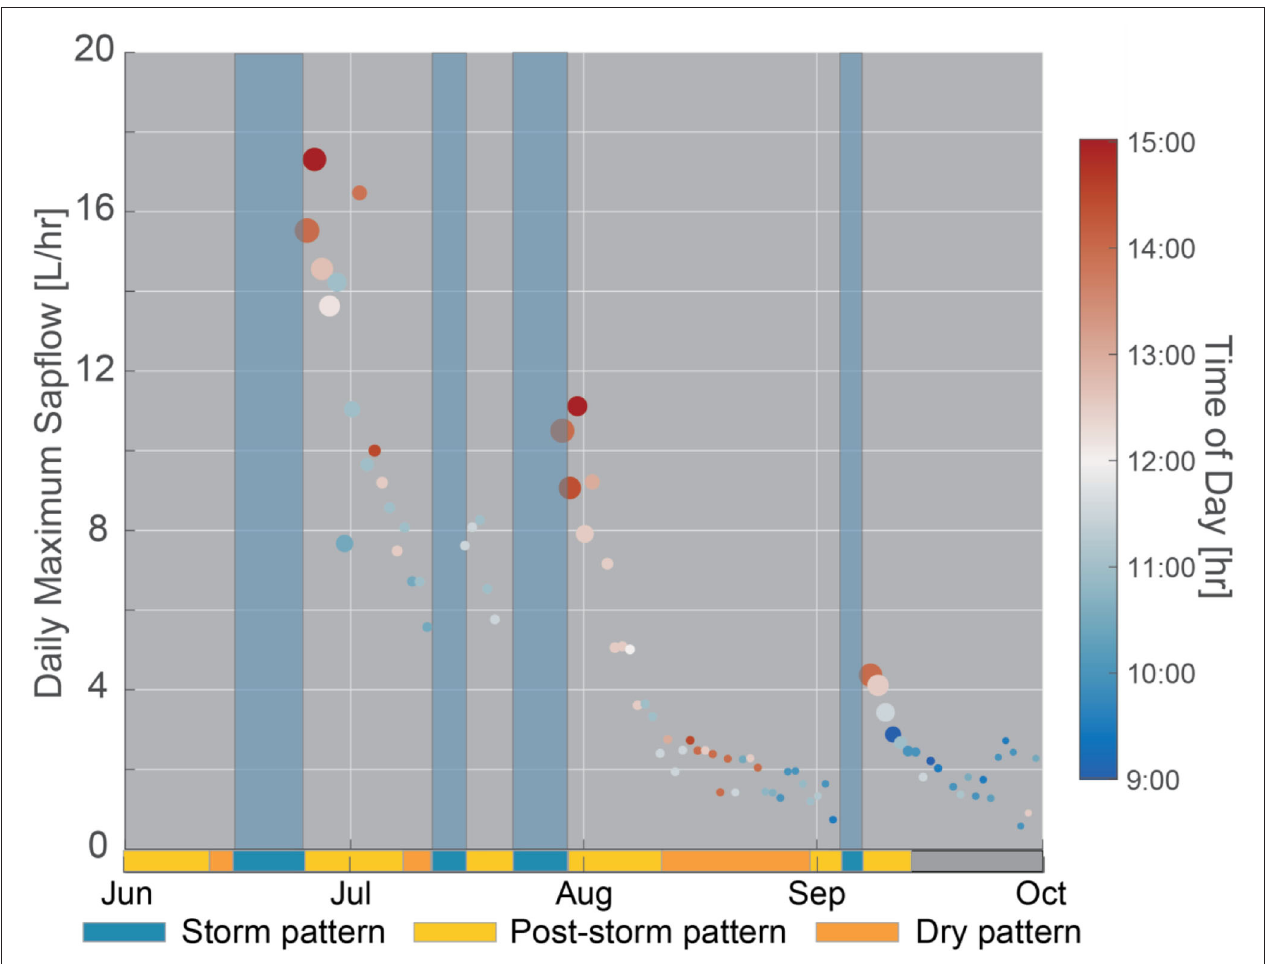
FIGURE 5 | Daily maximum sapflow through time. Points within storm events were removed because the time of maximum sapflow was controlled by the timing of the storm event. Dot size indicates soil moisture and dot color denotes the time of peak sapflow. Shaded blue regions across all subpanels correspond to storm patterns. On the bottom x-axis, a single bar denotes three distinct patterns (storm, post-storm, and dry pattern) observed in the diel fluctuations of inverted sapwood electrical conductivity, described in detail in section Temporal Patterns in Inverted Sapwood Electrical Conductivity. The gray bar corresponds with the period when patterns could not be distinguished due to noise in inverted sapwood electrical conductivity